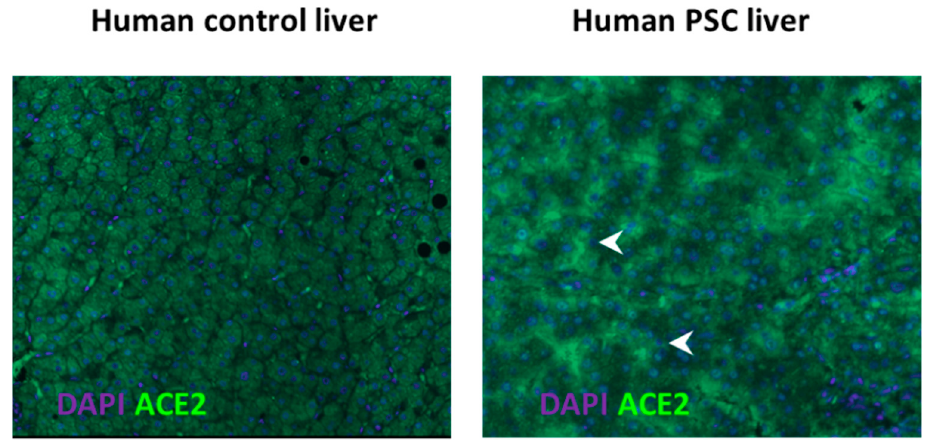
Figure 3. ACE2 protein expression in the liver of healthy controls and in patients with primary sclerosing cholangitis (PSC). Angiotensin converting enzyme (ACE2), the expression of which is very low in healthy livers (left panel), is upregulated in the cirrhotic livers of patients with primary sclerosing cholangitis (PSC) (right panel). Upregulated ACE2 may be important in counter-regulating the ACE and angiotensin II-driven profibrotic effects of the classical renin angiotensin system. Arrowhead, ACE2 staining; DAPI, nuclear staining; magnification, ×100.